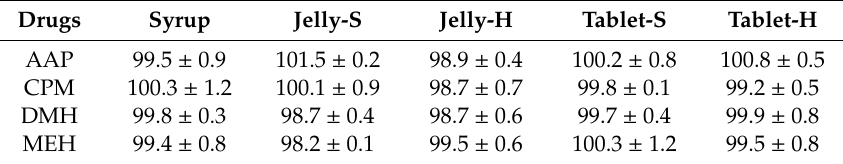
Table 3. Drug content in each formulation (% nominal content ± standard